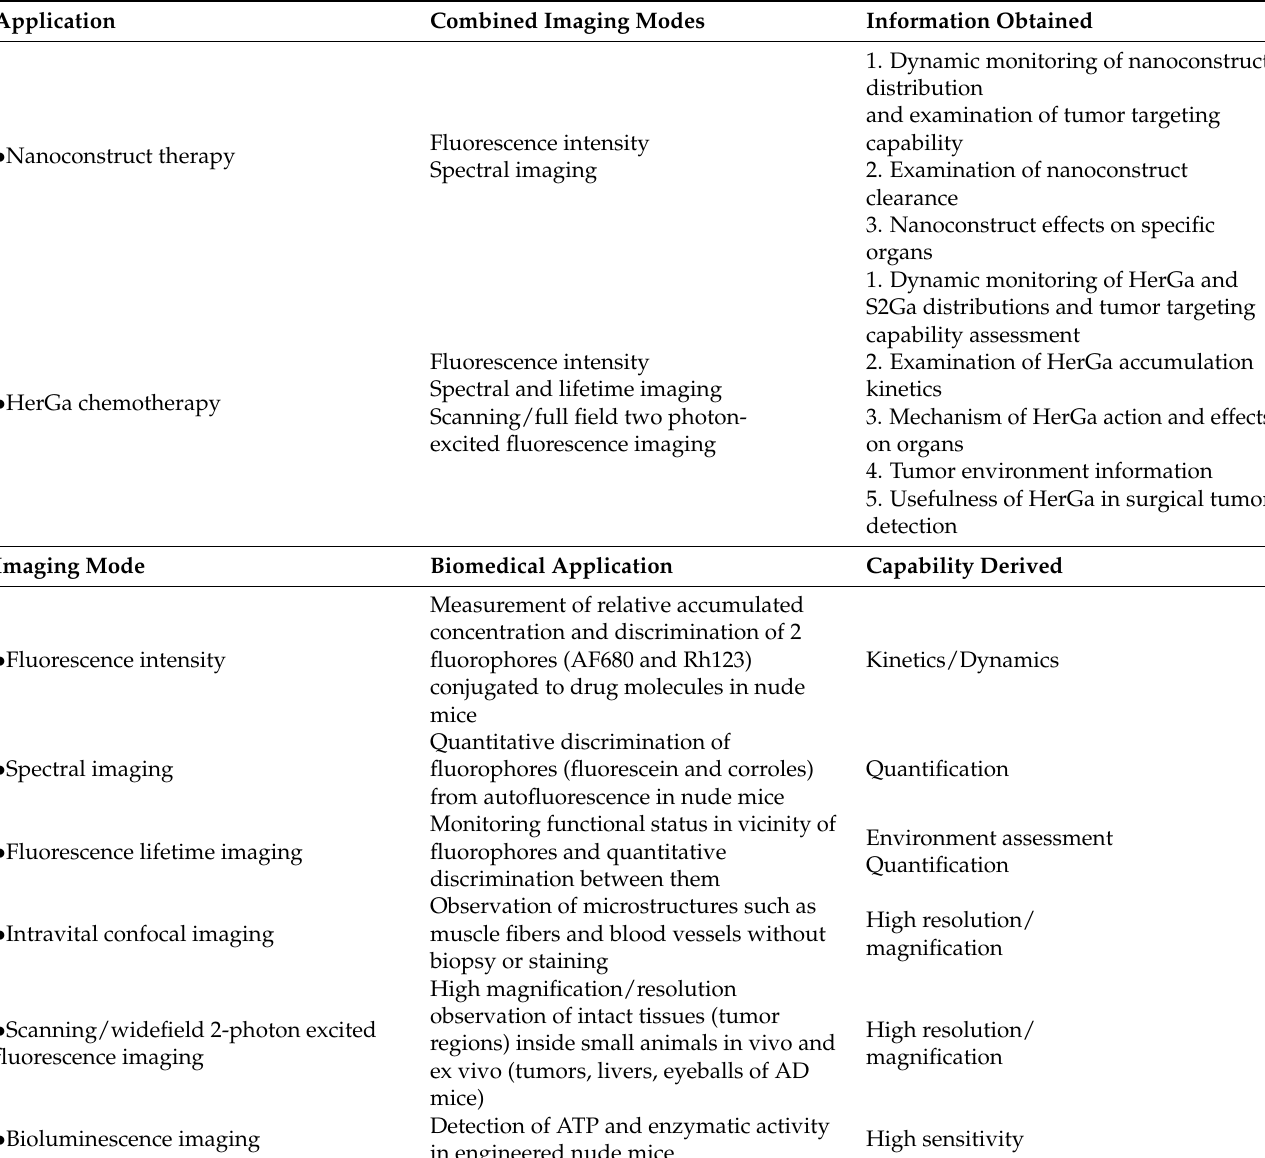
Table 1. Multimode assessment of nanoconstructs and HerGa chemotherapy (top) and application and capabilities of each imaging mode in the multimode panel (bottom)